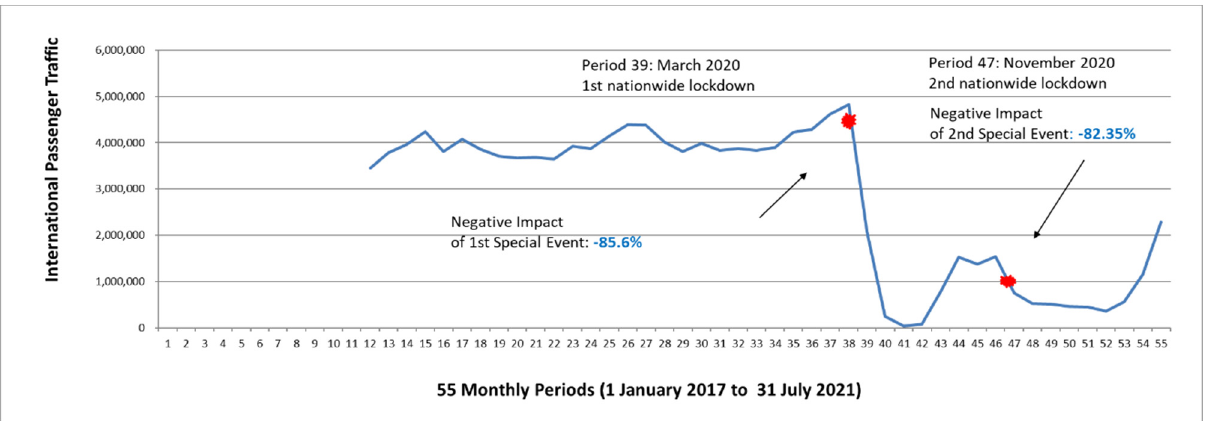
Figure 4. Special Events’ impact on international pax air traffic in Greece.